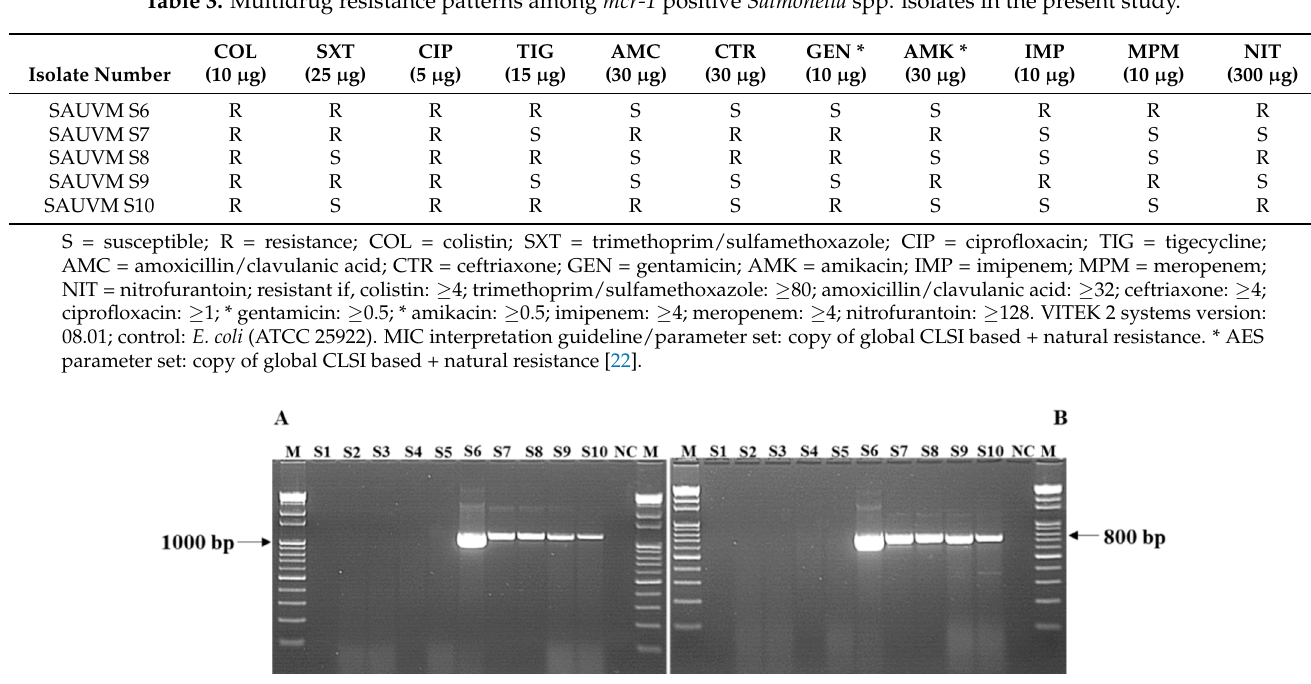
Figure 2. PCR amplification of antimicrobial resistance mcr-1 gene of Salmonella isolates. In Salmonella (S6 to S10) isolates, fragments of ( A ) 1197 bp and ( B ) 799 bp were detected. Lane M: DNA ladder. Lane NC: negative control. Lanes S1 to S5 represents mcr-1 negative isolates while lanes S6 to S10 represents mcr-1 positive Salmonella isolates SAUVM S6 to SAUVM S10. SAUVM